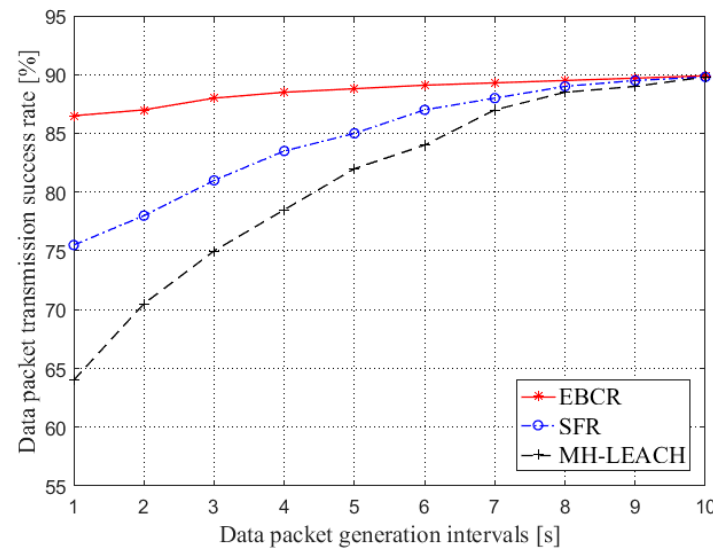
Figure 13. Comparison of the data packet transmission success rate (generation intervals).